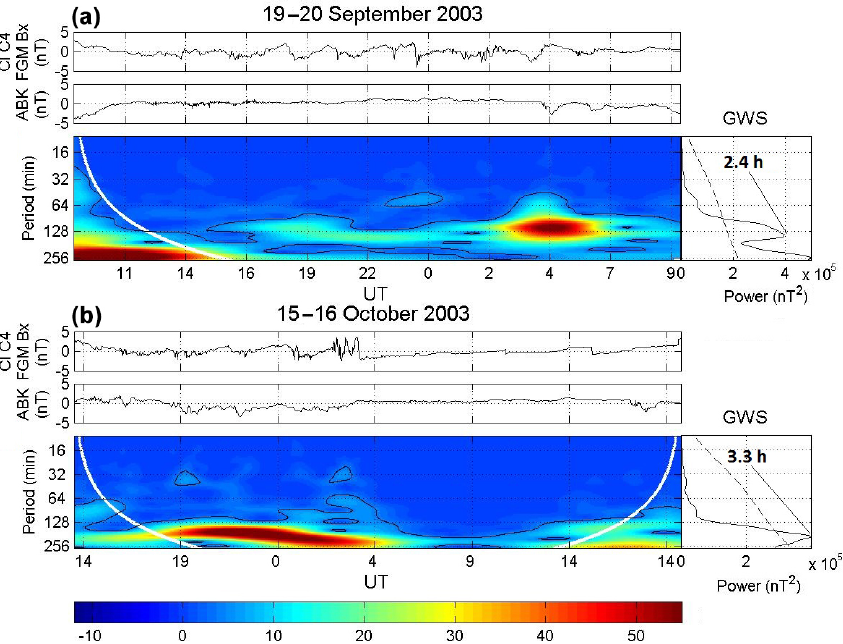
Figure 9. Cross-wavelet spectra between Cluster B x component data and ABK (Abisko) ground station geomagnetic data for the (a) 19– 20 September 2003 tail crossing (T2) and for the (b) 15–16 October 2003 tail crossing (T5). Otherwise the format is the same as for Fig. 4.